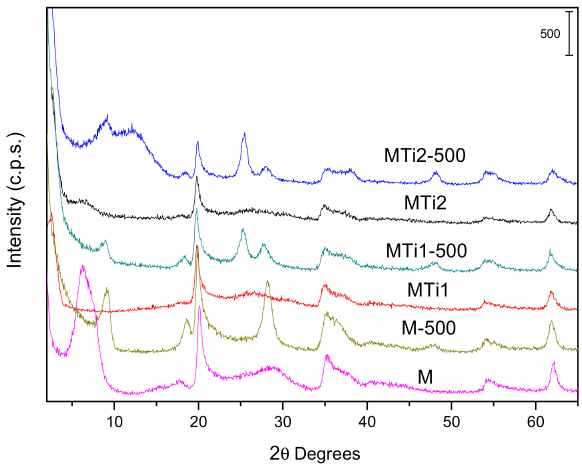
Figure 1. Powder X-ray diffractograms of the parent montmorillonite and the catalysts synthesized. For comparison, the diffractograms of dried and calcined (denoted “ − 500”) solids are